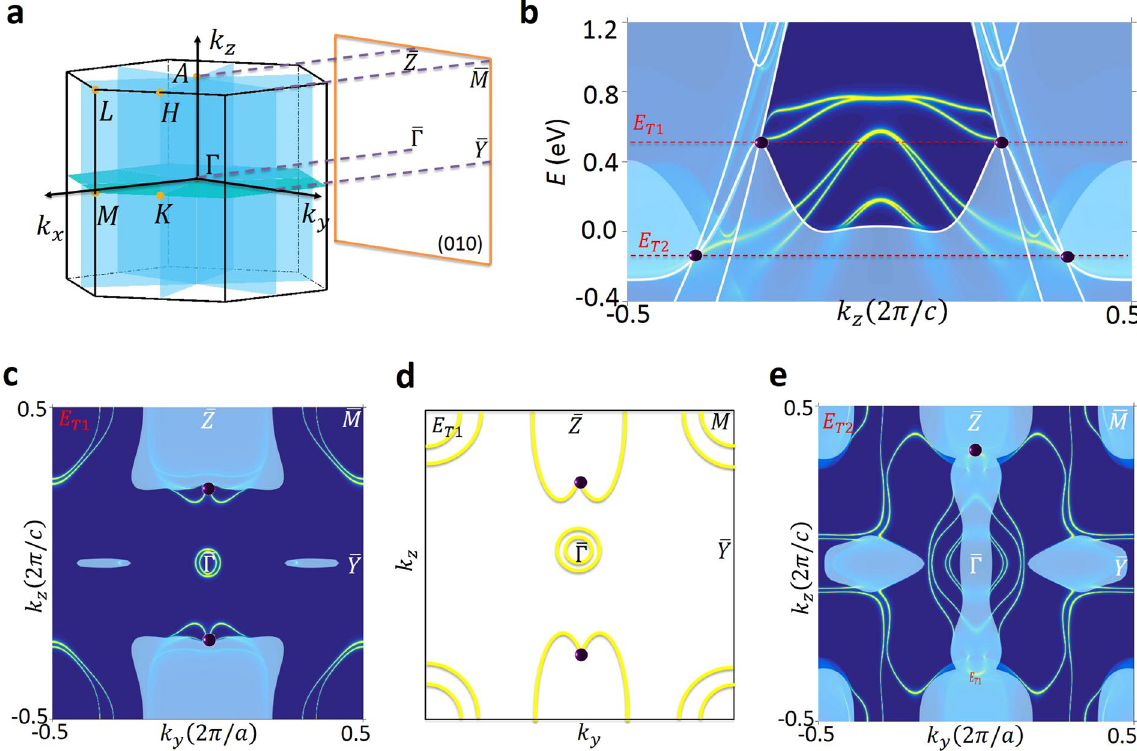
Figure 5. Topological surface states in the new TM. ( a ) The bulk BZ and the (100) surface BZ of WC. ( b ) ∼  A line). The white lines show the bulk bands, and the purple Surface band structure along the k z axis (the Γ − spheres denote the triply-degenerate nodes. ( c , e ) Surface constant energy contours at the energies of the two triply-degenerate nodes. ( d ) Schematic illustration of the surface state Fermi arc connectivity in